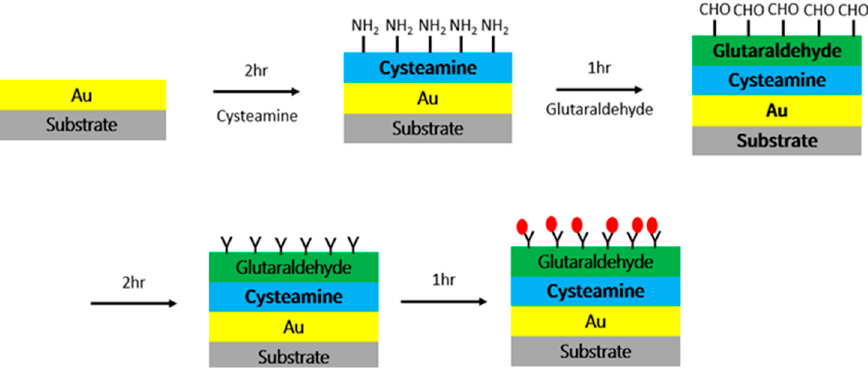
Figure 3. Process of antibody modification of the surface of the sensing device.